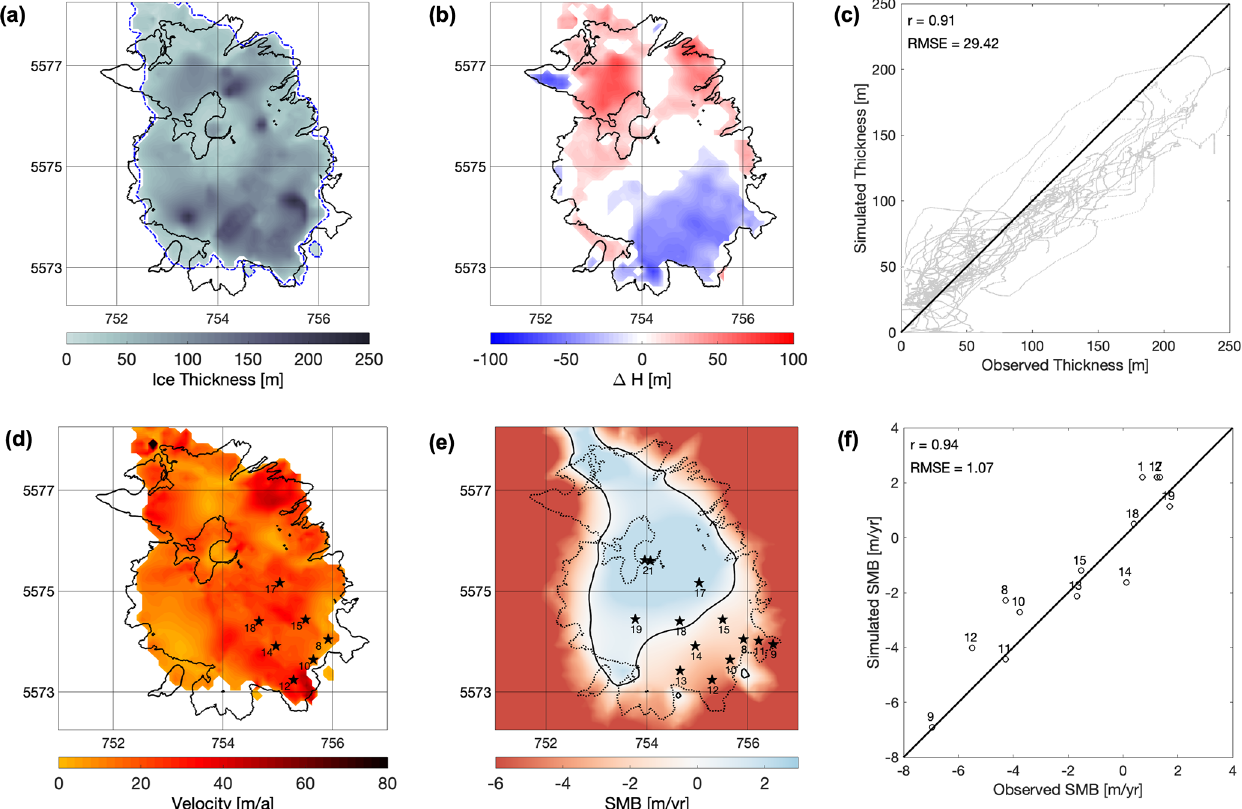
Figure 6. Results of the transient spin-up for 2013. (a) Ice thickness distribution with observed (black) and modelled (blue) extent, (b) dif- ference between modelled and observed ice thickness, (c) modelled thickness against observed thickness along radar profiles, (d) surface flow velocity and stakes with velocity observations, (e) modelled surface mass balance over model domain with SMB stakes as black stars and simulated ELA as solid black line, and (f) modelled SMB against observed SMB at